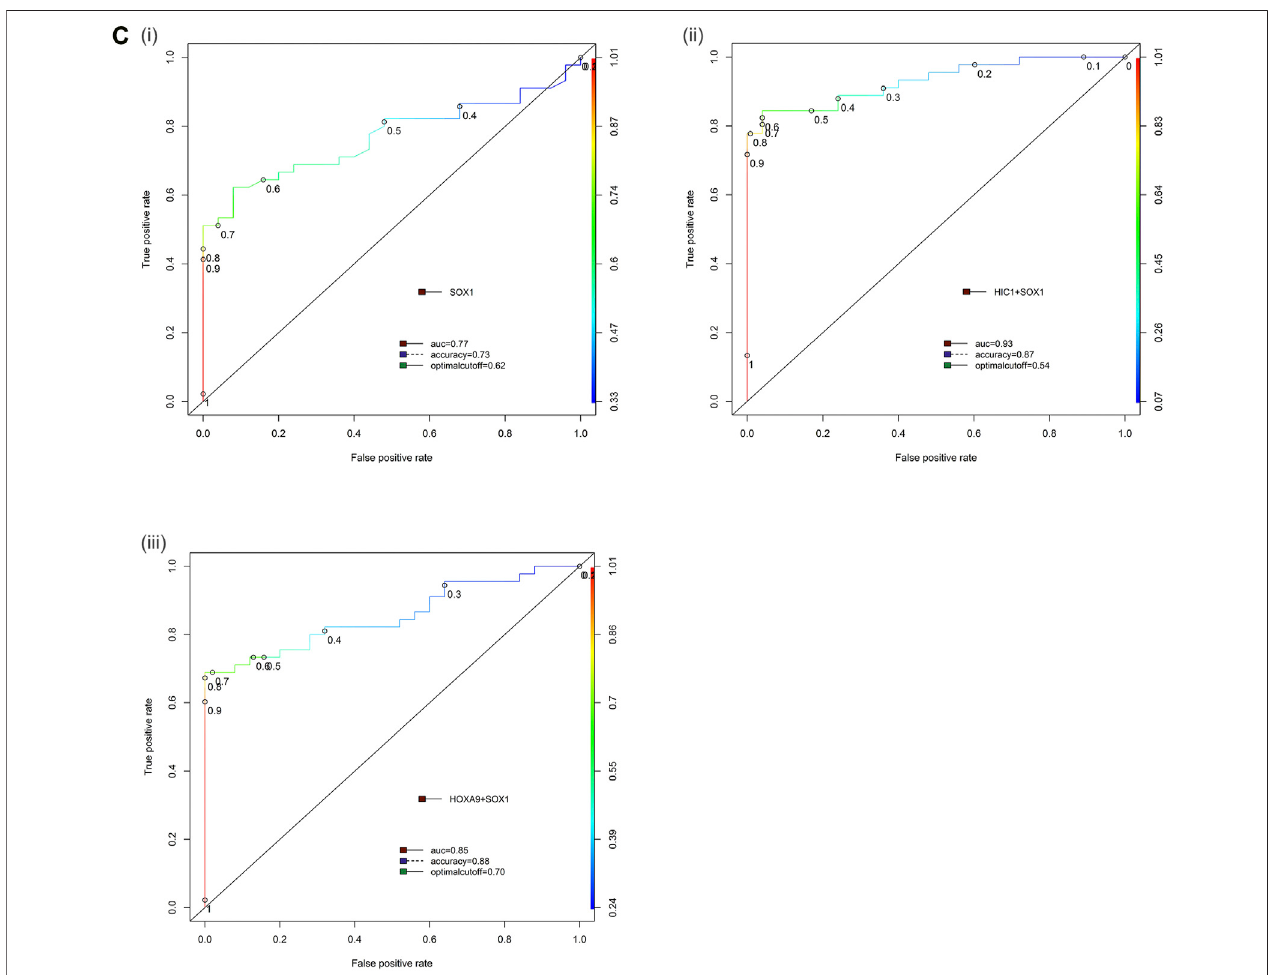
FIGURE6| Receiver operator characteristic (ROC) curve differentiating EOC patients from healthy controlin serum samples. TheareaundertheROCcurve(AUC) suggests the accuracy of the biomarkers in distinguishing ovarian carcinoma from normal healthy control sample, is depicted for the biomarkers (Ci) SOX1, (ii) HIC1+SOX1and (iii) HOXA9+SOX1respectively.[CombinedtwoDNAmethylationmarkerpanel]whichisbasedonthesumofthetwoPMRvalues.AUC:areaunderthe curve. The ROC curve for biomarker panel HOXA9+HIC1 in serum samples has been previously published (Singh et al., 2020).